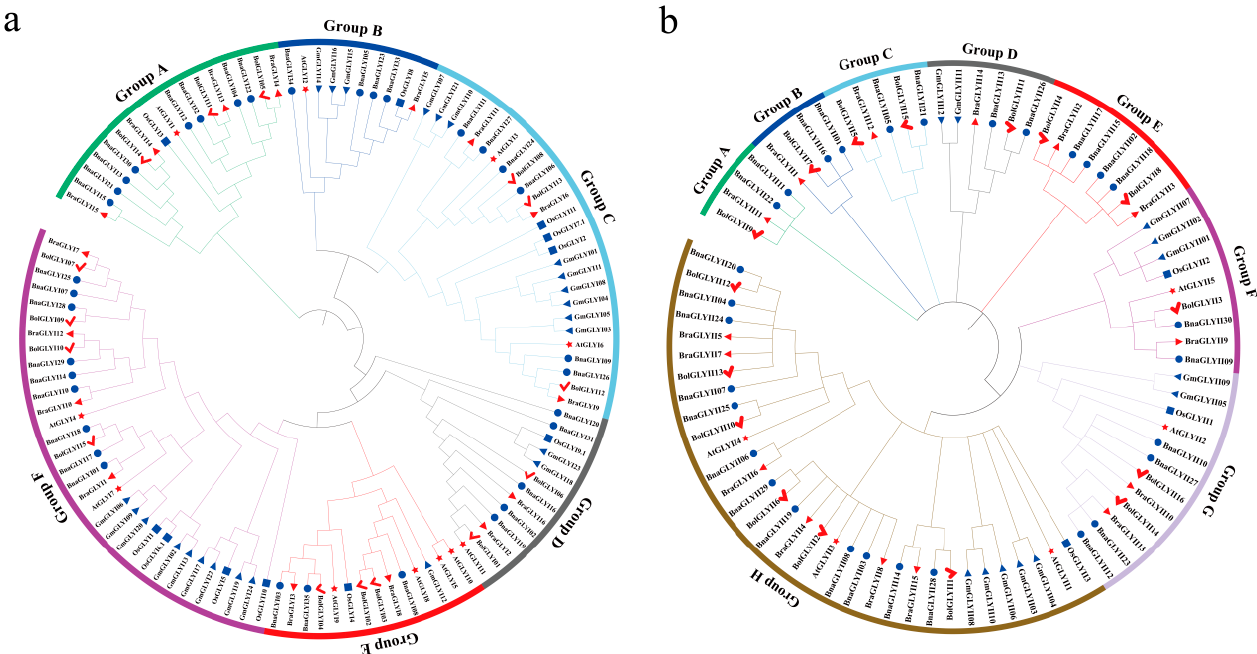
Figure 3. Phylogenetic relationships of BnaGLYI ( a ) and BnaGLYII ( b ) from various plant species. A phylogenetic tree was constructed based on the multiple alignment results, using MEGA 7.0 software with the Neighbor-Joining method. Bootstrap support from 1,000 reiterations is indicated above the branches. The 112 GLYI proteins from B. napus (35), B. rapa (16), B. oleracea (15), Arabidopsis (11) G. max (24) and O sativa (11) were used in phylogenetic analysis of BnaGLYI ( a ), and the 81 GLYII proteins from B. napus (30), B. rapa (15), B. oleracea (16), Arabidopsis (5), G. max (24) and O sativa (3) were used in phylogenetic analysis of BnaGLYII ( b ). Only the first splice variants were considered in the case of multiple members, respectively. “At”, “Bra”, “Bol”, “Gm” and “Os” refer to the proteins in A. thaliana , B. rapa , B. oleracea , G. max and O sativa . Proteins from B. napus , B. rapa , B. oleracea , Arabidopsis , G. max and O sativa are marked with solid circles, red triangles, check marks, stars, blue triangles and squares, respectively. The sequences used in the analysis are listed in additional data sheet (Table S7).